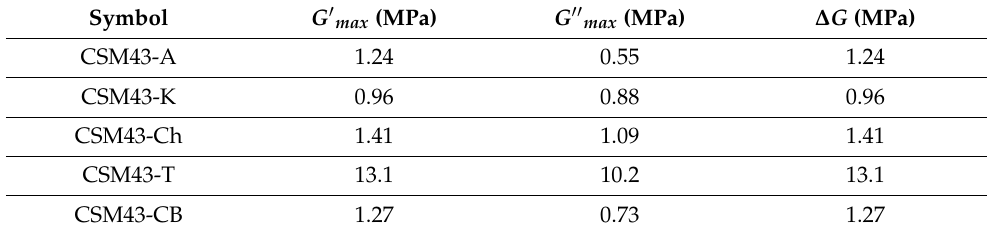
Table 9. Payne effect of filled CSM43 vulcanizates; T = 160 ◦ C, t v = 5–15 min.